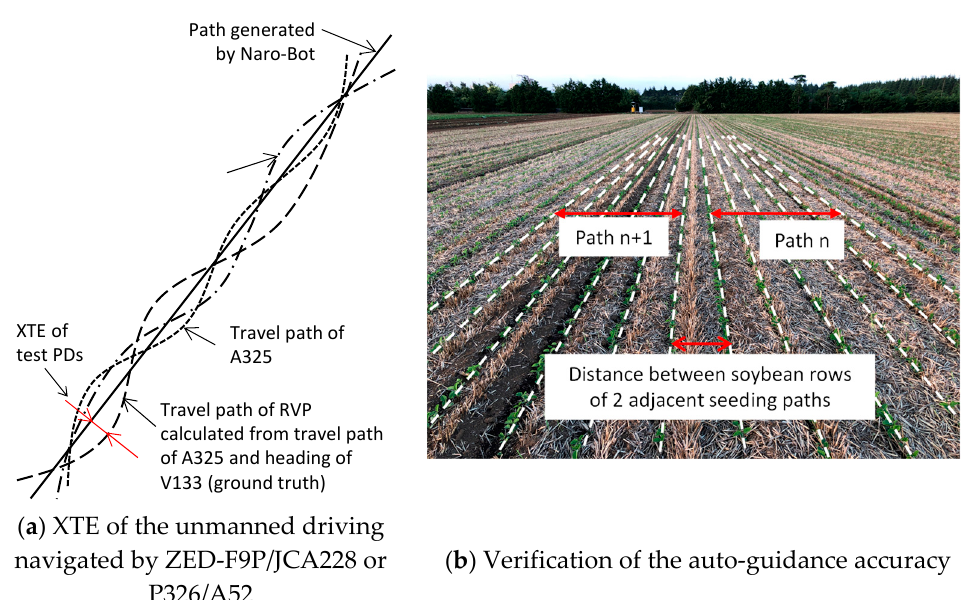
Figure 5. Methods for determining the auto-guidance accuracy of the test PDs during automatic soil tilling and seeding.